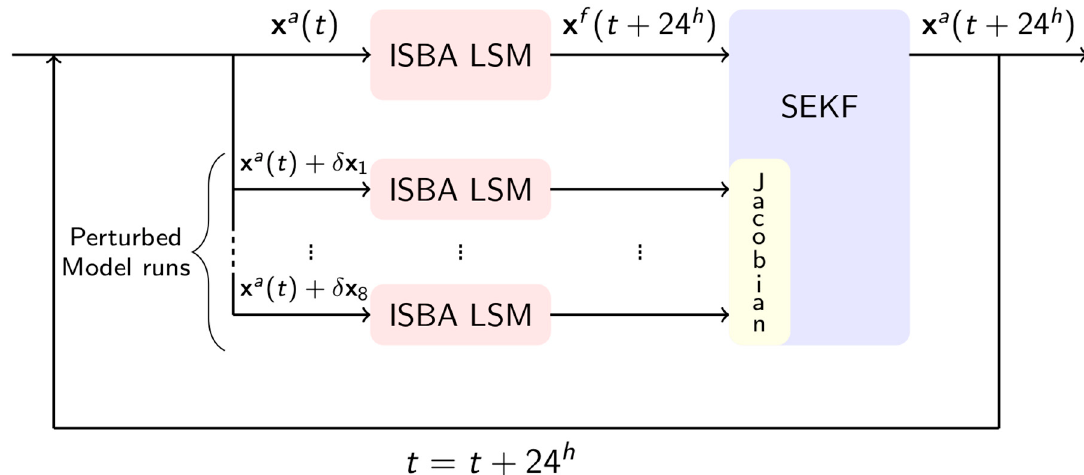
Figure 2. Diagram depicting the sequential cycle of LDAS-Monde using an SEKF. The forecast step consists of propagating the analysis at previous time step to the next one using the ISBA LSM. The analysis step corrects the forecast by assimilating observations. The SEKF involves the computation of a Jacobian matrix obtained through perturbed model runs initialized by the analysis at a previous time step slightly perturbed by a small amount ( δ x 1...8 ). The number of perturbed model runs is equal to the number of control variables (in our case, eight variables).